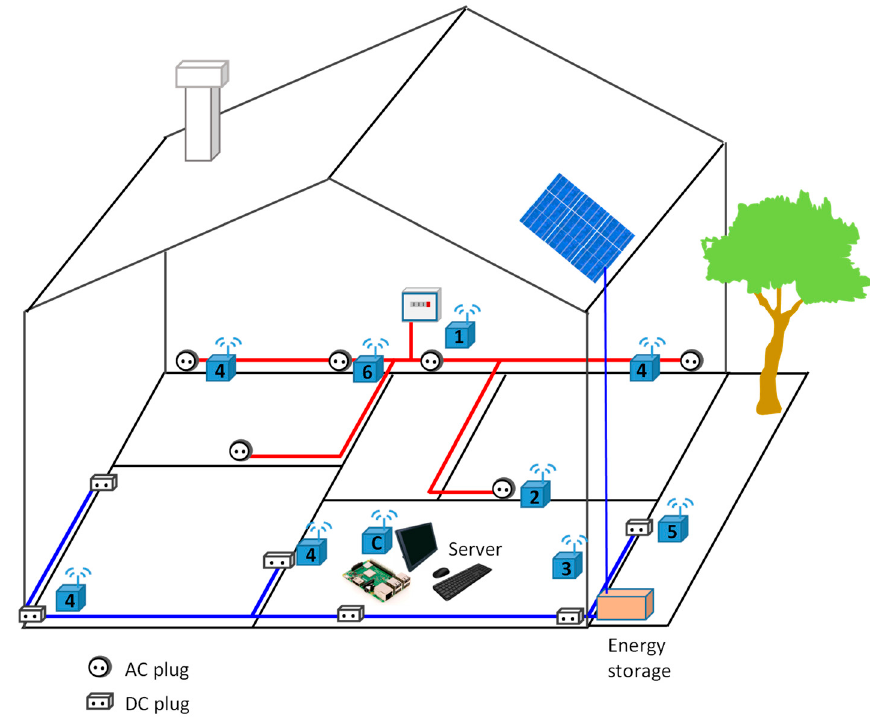
Figure 1. System Figure 1. System architecture.